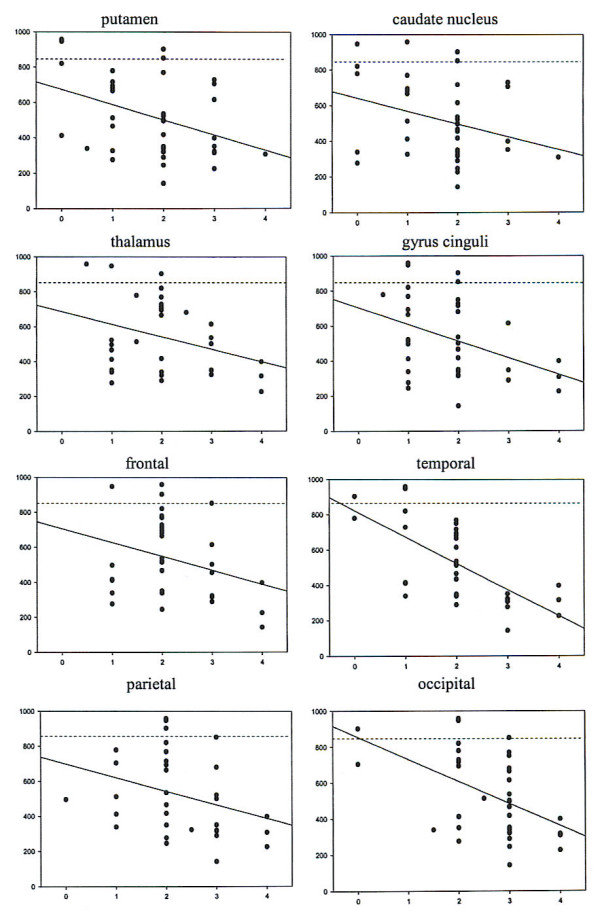
Correlation between Aβ1–42 CSF levels and degree of neuronal loss in various brain areas. (- - - - - - cut-off 849 pg/ml).